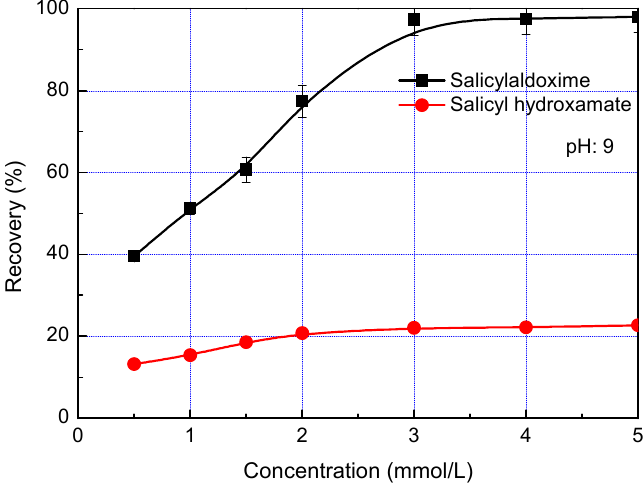
Figure 7. Flotation of malachite as a function of salicylaldoxime and salicyl hydroxamate concentrations.